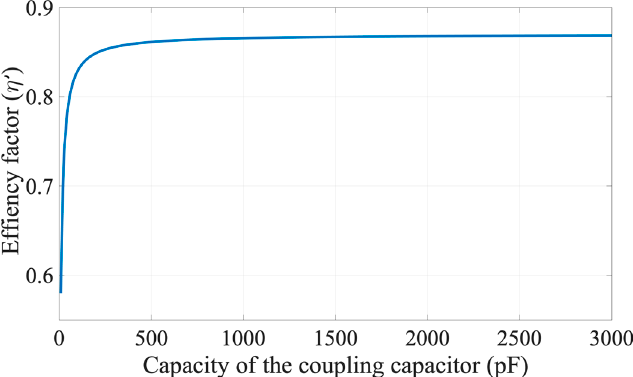
Figure 5. The variation of efficiency factor with coupling capacitor.